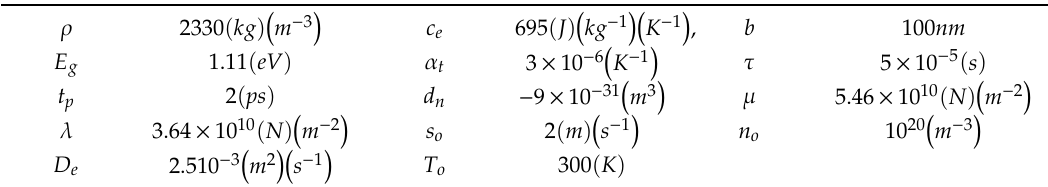
Table 1. The values of physical